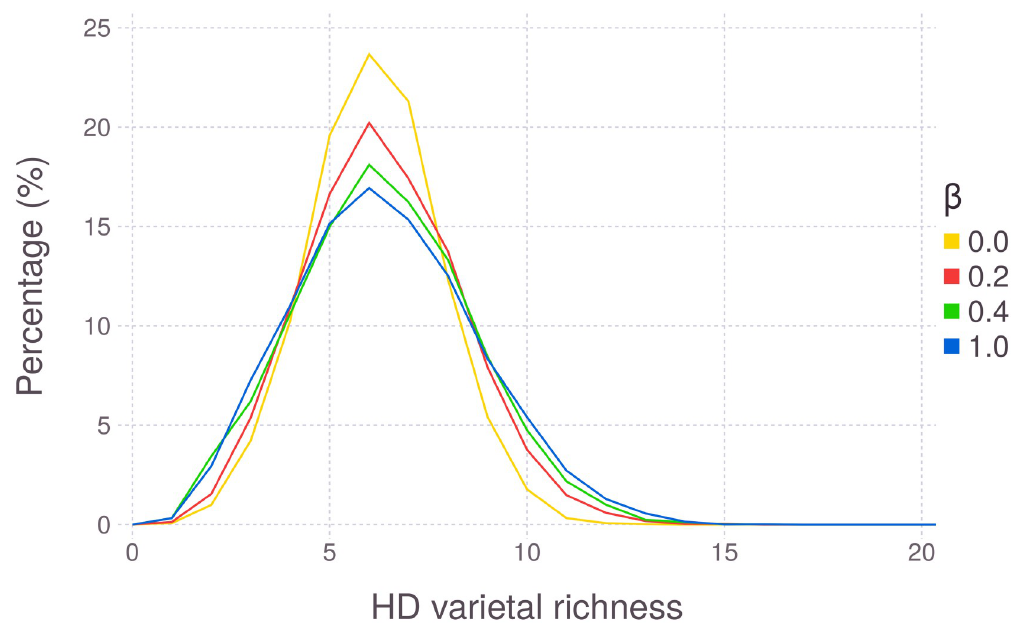
Fig 8. Distribution of HD varietal richness at the end of the simulation, varying the Watts-Strogatz network rewiring probability ( β ). β = 0 results in a regular network, and β = 1 results in a random network. Each line represents the aggregation of 200 runs.